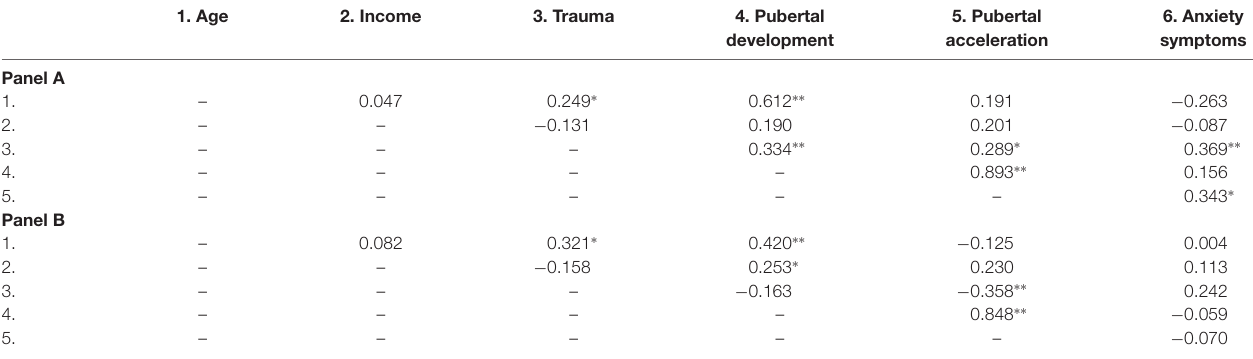
TABLE 2 | Correlations between all study variables for girls (Panel A; n = 64) and boys (Panel B; n = 67). 1. Age